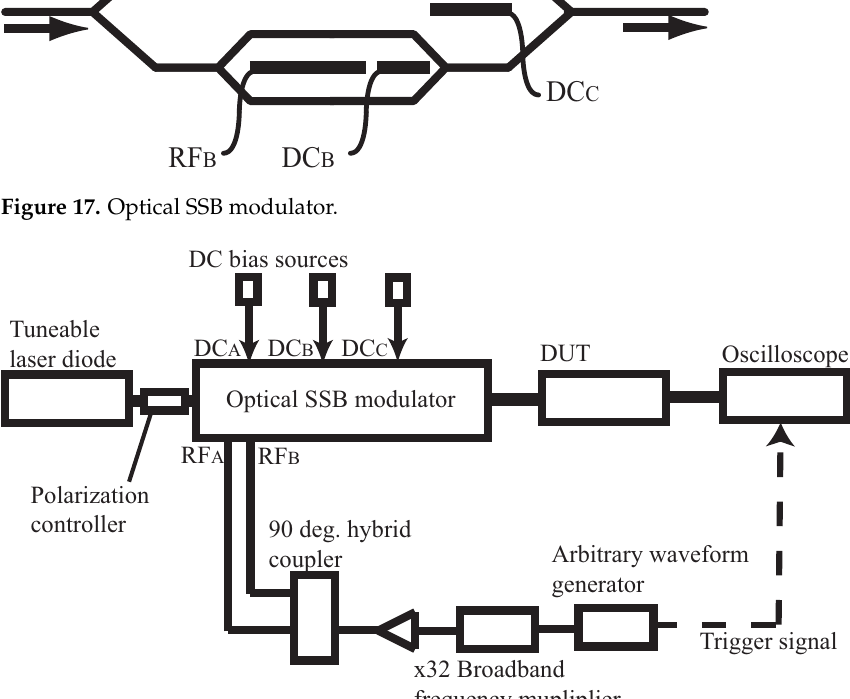
Figure 18. Setup for optical frequency